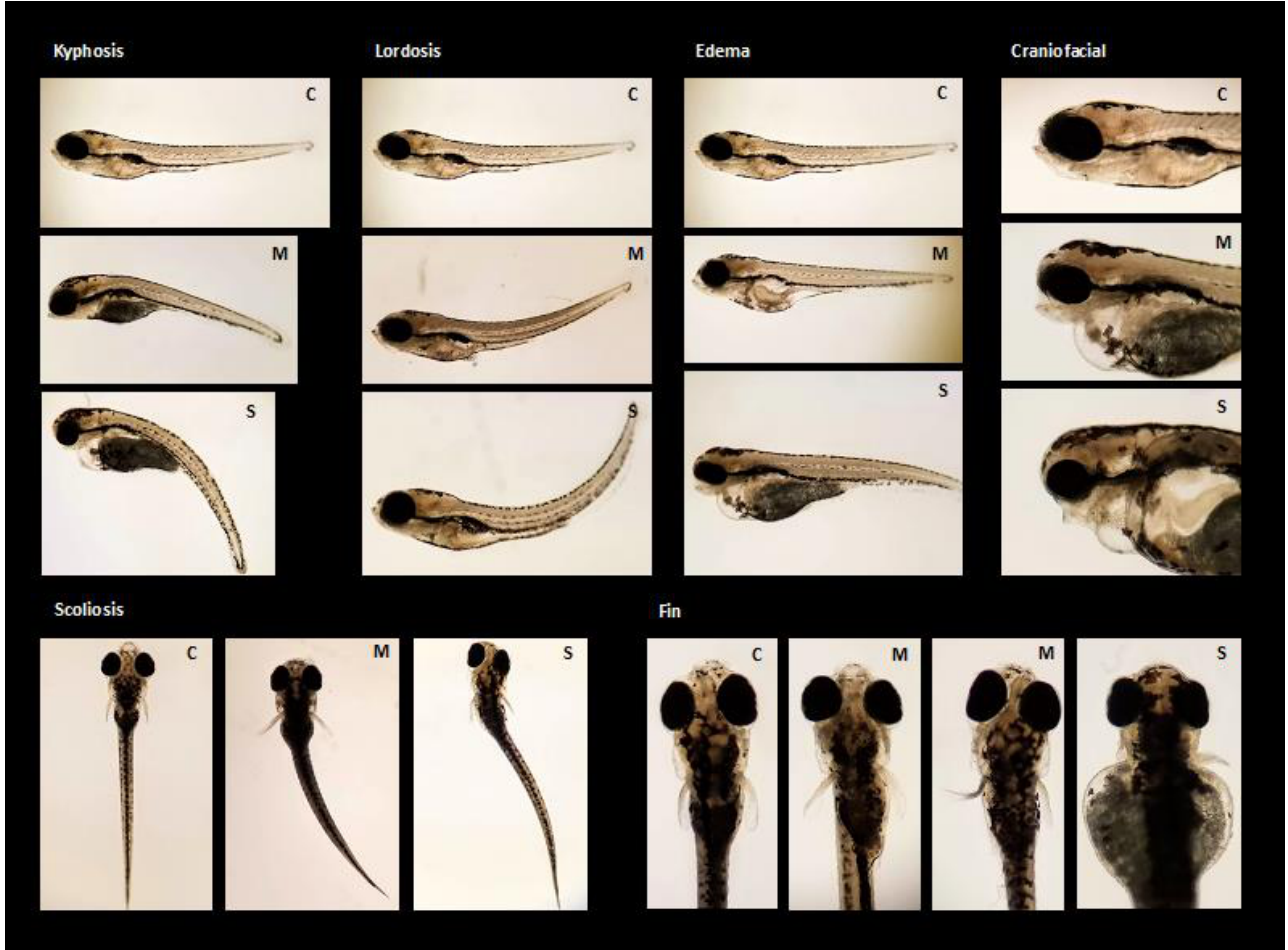
Figure 2. Morphological malformations at varying degrees of severity observed in larval zebrafish exposed to increasing concentrations of L-selenomethionine (SeMet) via embryo aqueous exposure during deformities analysis. Letters indicate level of severity; Control (C), Moderate (M), and Severe